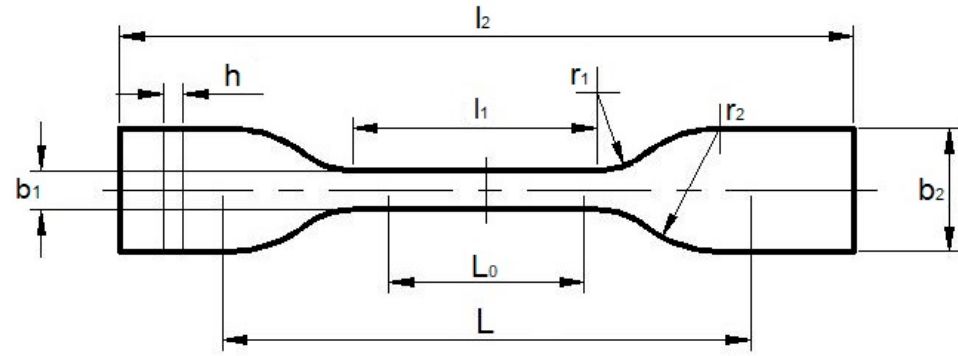
Figure 10. The shape of the specimen according to ISO 527:1-1993.